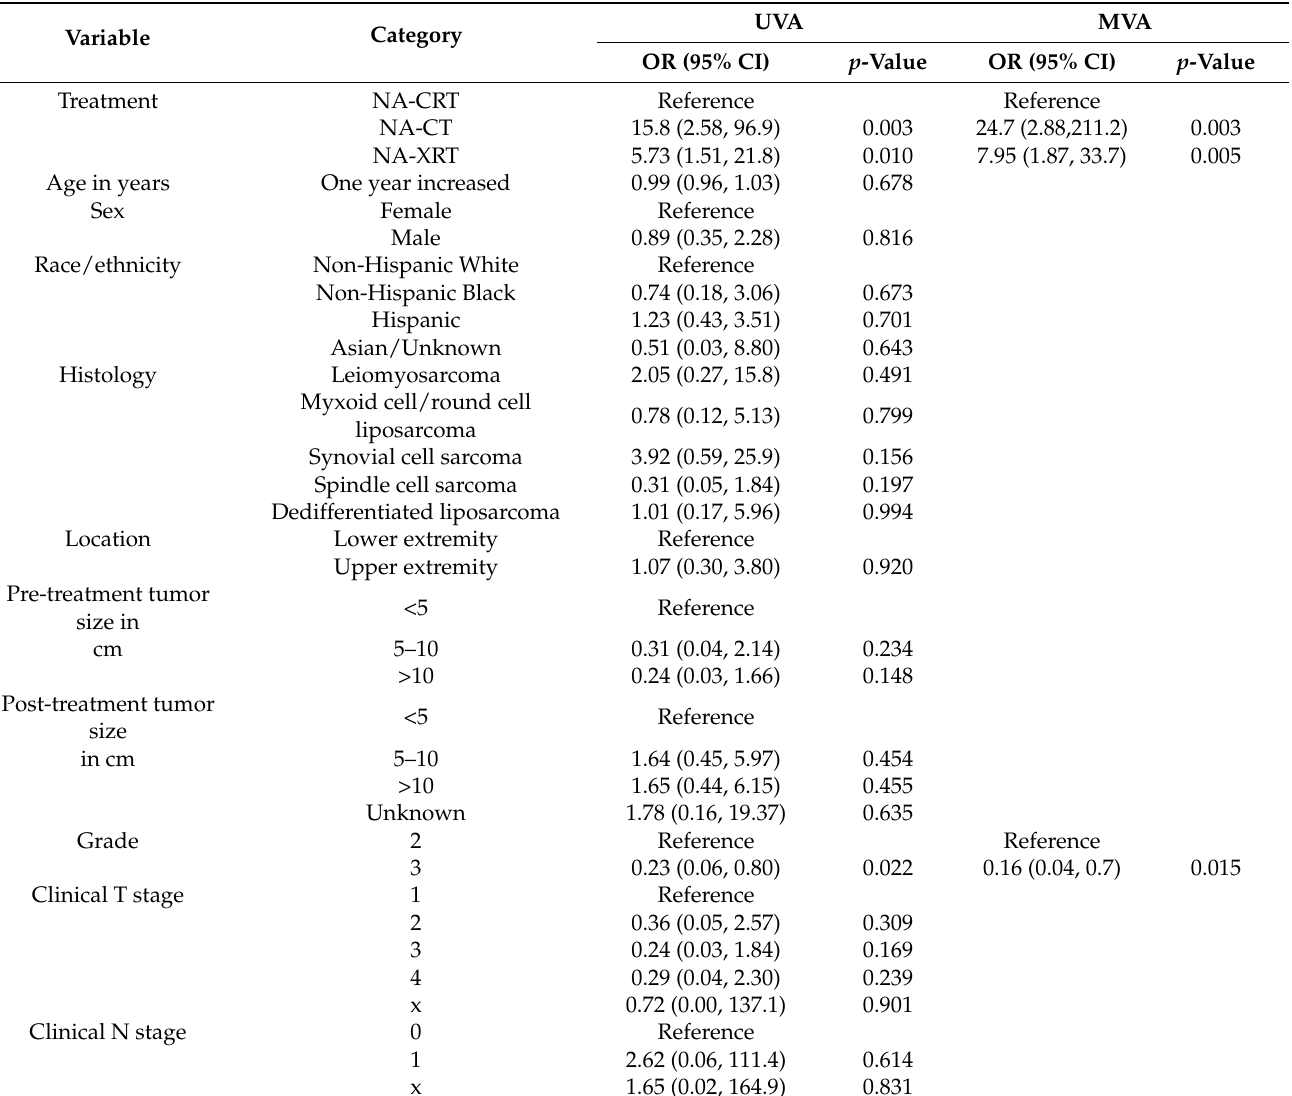
Table 3. Logistic regression: Effect of treatment on pCR vs. Non ‐ pCR.